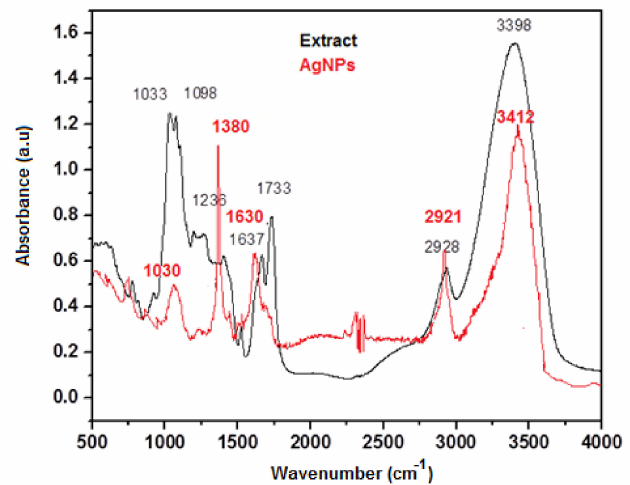
Figure 4. FTIR spectra of the fruit extract and phytosynthesized AgNPs.